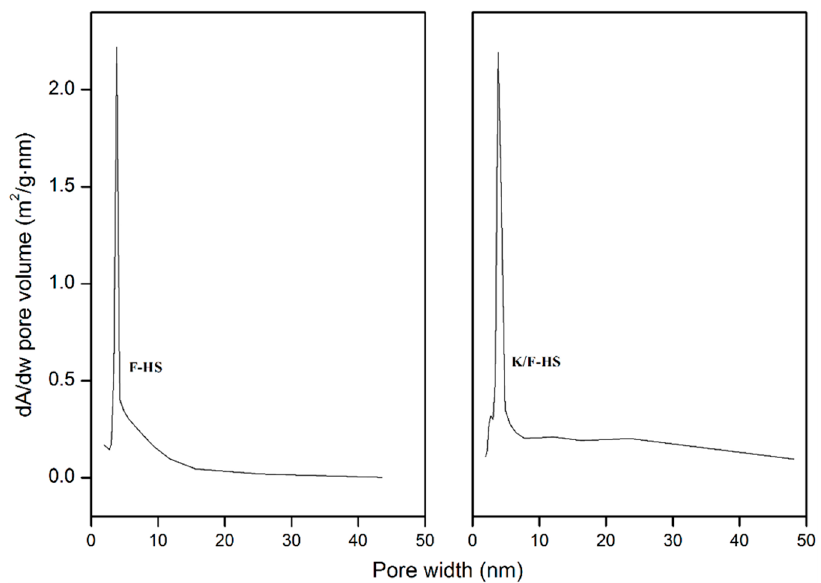
Figure 4. Pore size distribution of fusion-assisted hydrothermal F-HS and ion exchange-modified K/F-HS zeolite. Table 3. Properties of biodiesel derived from maggot oil using the fusion-synthesised and ion exchange modified HS zeolite